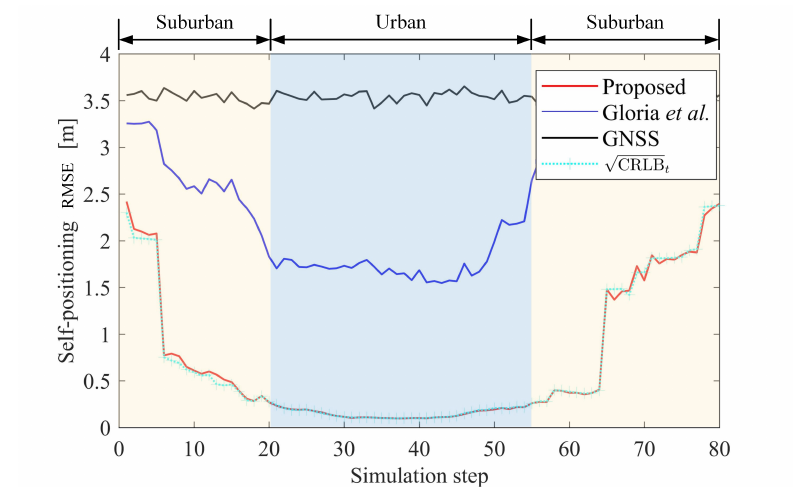
Figure 6. Self-localization error.